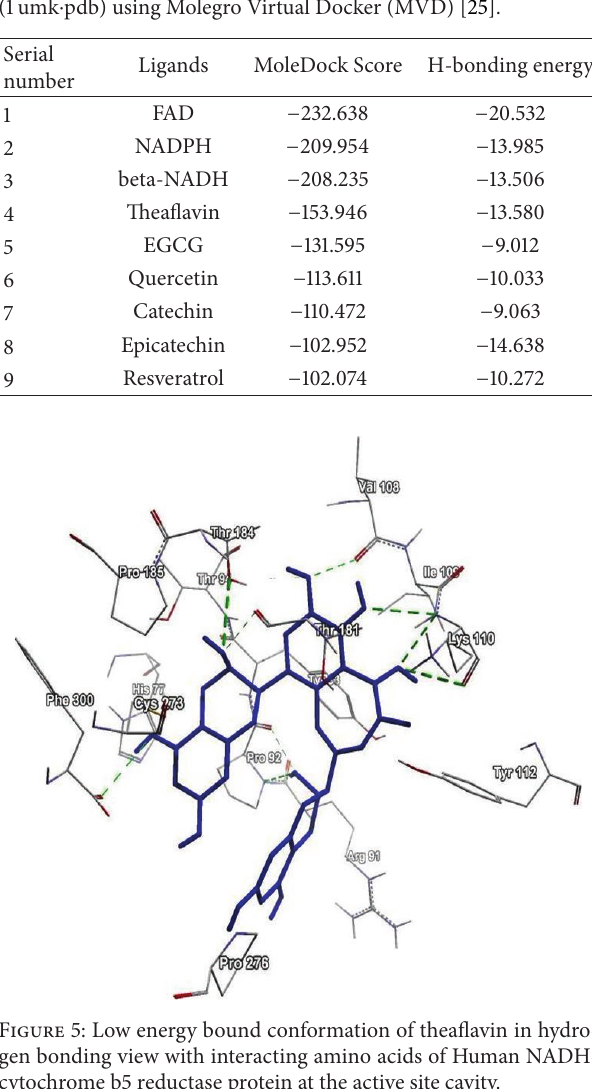
Table1:Comparativedockingsimulationresultofselectedpolyphe- nols with Human NADH-cytochrome b5 reductase together with FAD, ligand from X-ray crystallized data of protein data bank